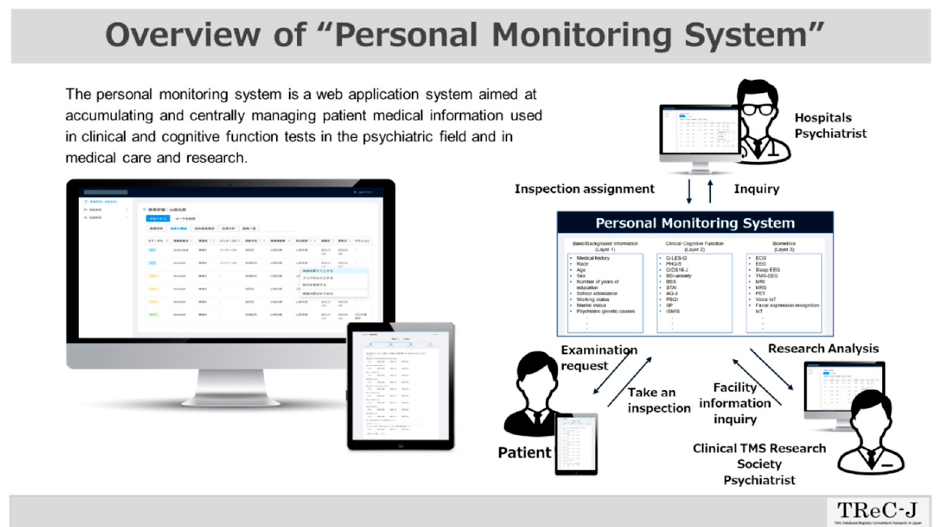
Figure 3. Overview of the Personal Monitoring System. We have developed a unique application software for personal monitoring dedicated to this TMS registry, and have constructed and imple- mented a system that enables data input and the confirmation and approval of examination results via PC and tablet terminals at each of the medical institutions collaborating in this project.